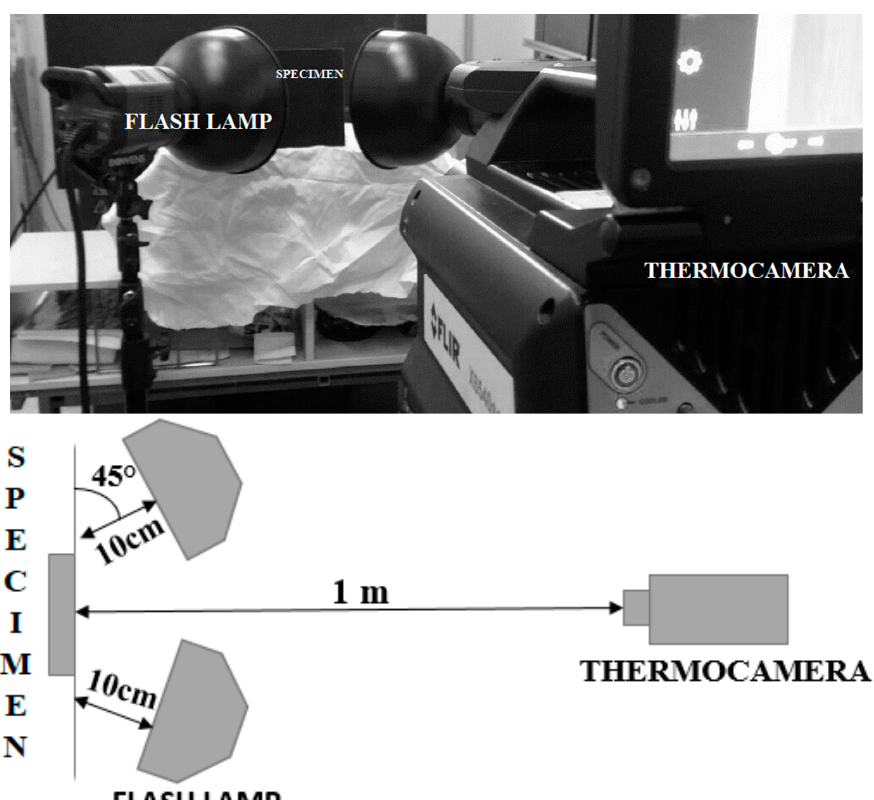
Figure 6. Set-up used for pulsed thermography test.